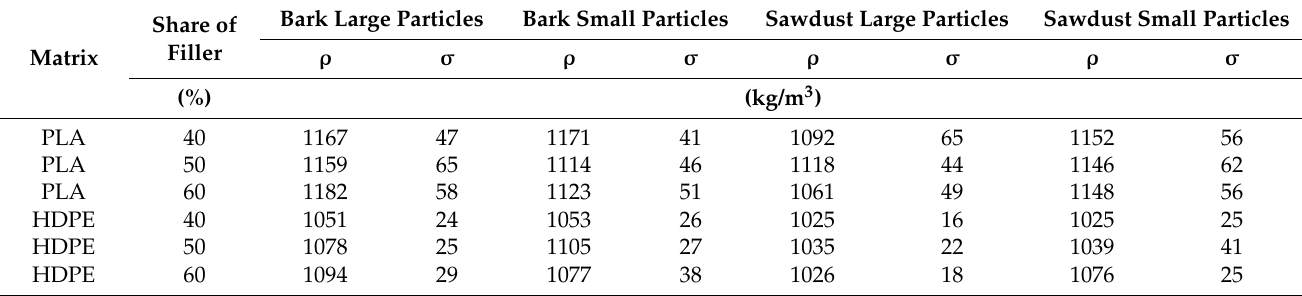
Table 3. The mean density values for individual variants of panels without additives.